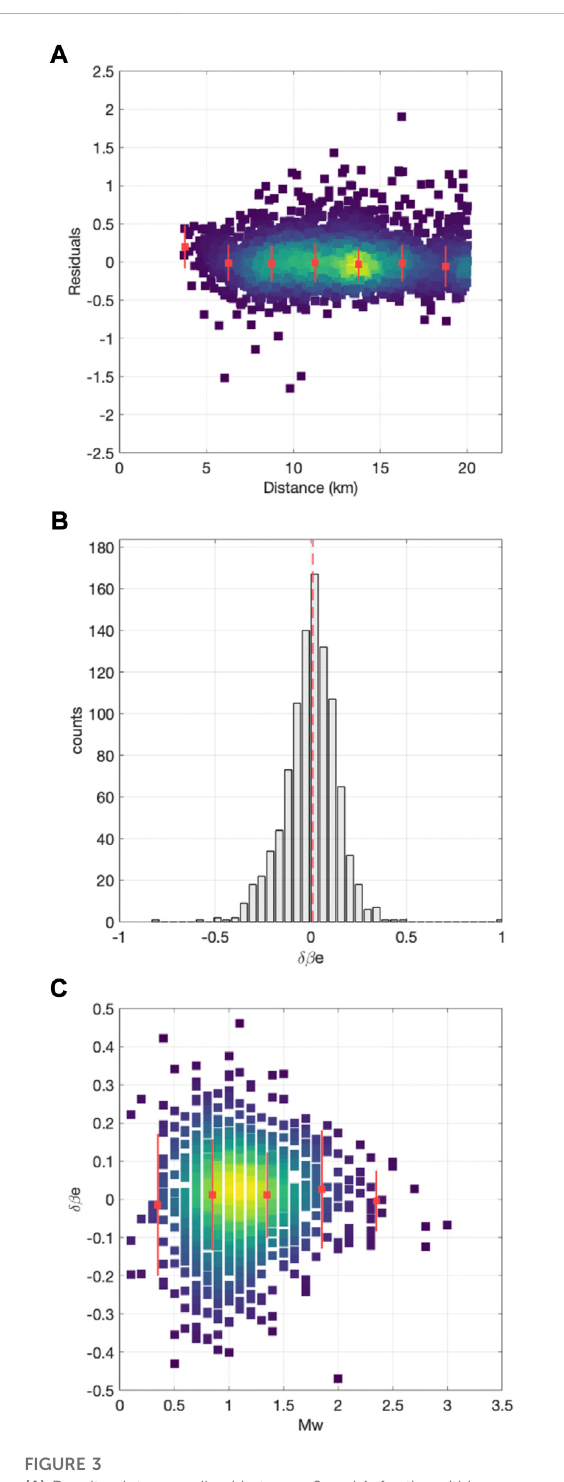
FIGURE 3 (A) Density plot, normalized between 0 and 1, for the within- event residuals ( ε ) versus the hypocentral distance; median (red squares) and standard deviation (red lines) of ε , computed for bins of the residuals in hypocentral distance (viridis color scale with yellow indicating higher density of data, as in Figure 1). (B)